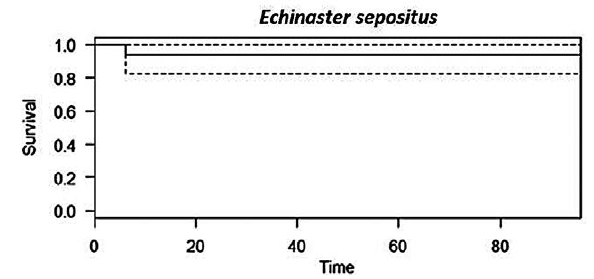
Fig. 5. – K-M model to assess the survival of Echinaster sepositum at vitality level